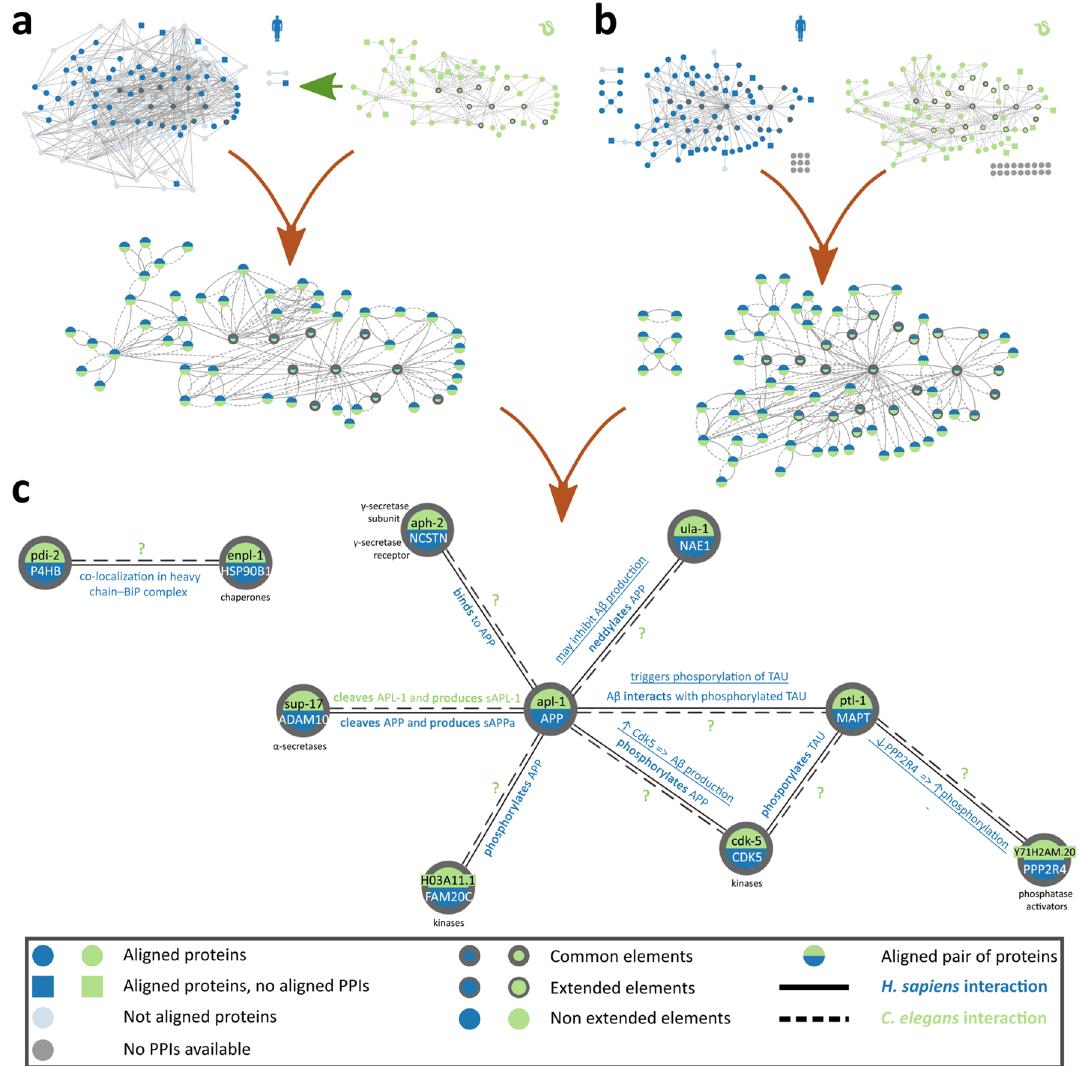
Figure 2. Alignments for the “ APL‑1and PTL‑1 network from STRING ” and the “ Top 100 interaction partners ” datasets and their common elements. ( a ) The C. elegans APL-1 and PTL-1 network from STRING (green) and the homologous human network (blue), with the unified network resulting from their alignment below. ( b ) The Top 100 interaction partners of APL-1 and PTL-1 for the C. elegans network (green) and of APP and Tau for the human network (blue). Below these networks is the unified network resulting from their alignment. (c) The common elements of the two unified networks (pairs of proteins and their PPIs aligned similarly in both datasets). Omics Visualizer 31 was used to apply colors on the network’s nodes, with the green half representing the C. elegans protein and the blue half representing the human protein. Each half is labeled with their corresponding gene symbol (gene symbol for Tau is MAPT). All human interactions were annotated with at least one supporting publication (Supplementary Table 4); edges with underlined labels indicate annotations directly associated with AD. On the contrary, only one C. elegans interaction could be annotated as AD related based on literature